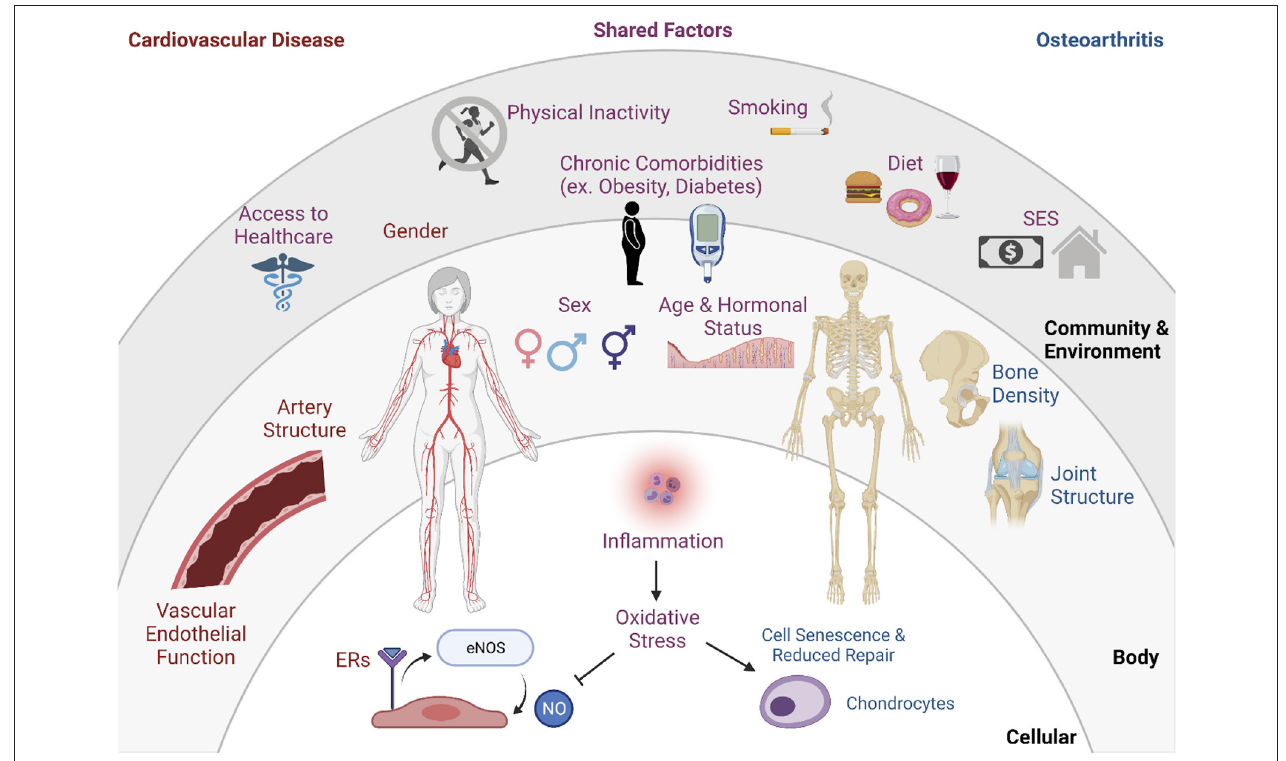
FIGURE 1 | Interaction of risk factors of OA and CVD. Factors with research to support connection to OA alone: cell senescence & reduced repair, chondrocytes, bone density, joint structure. Factors with research to support connection to CVD alone: gender, artery structure, vascular endothelial function estrogen receptors (ERs), eNOS (endothelial nitric oxide synthase), nitric oxide (NO). Shared risk factors include access to healthcare, physical inactivity, chronic comorbidities, smoking, diet, socioeconomic status (SES), sex, age, hormonal status, inflammation, oxidative